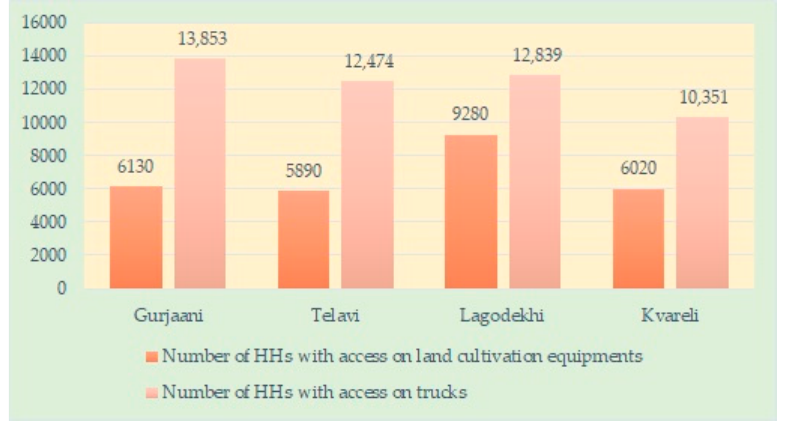
Figure 8. Utilization of land cultivation equipment and trucks (number of HHs).